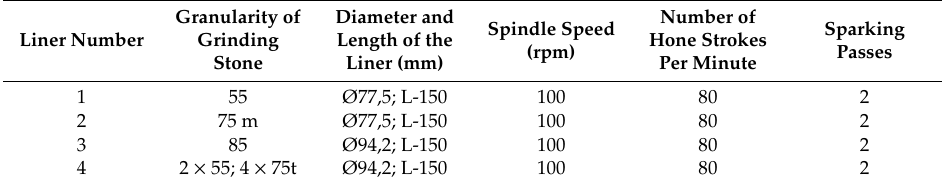
Table 1. Machining parameters of the tested liners.